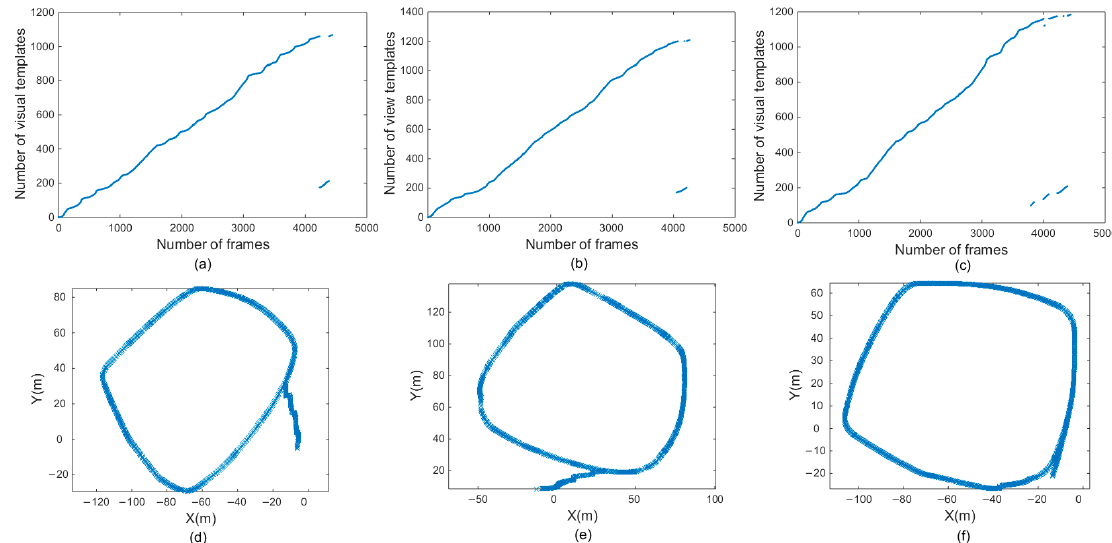
Figure 8. Experimental results of the first scene. ( a , d ) are visual templates and experience map output by traditional RatSLAM. ( b , e ) are visual templates and experience map output by RatSLAM based on FT model. ( c , f ) are visual templates and experience map output by RatSLAM based on HSI model.